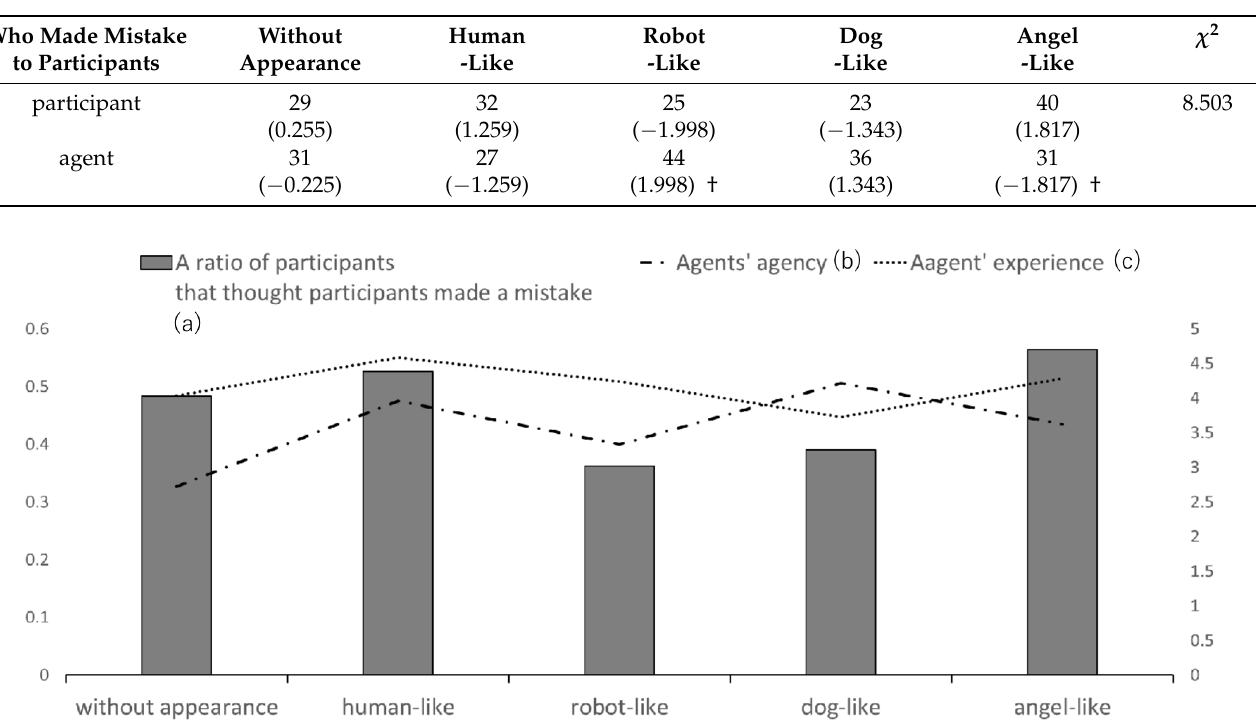
Table 7. Cross-tabulation of the number of participants who answered. † means p < 0.1.